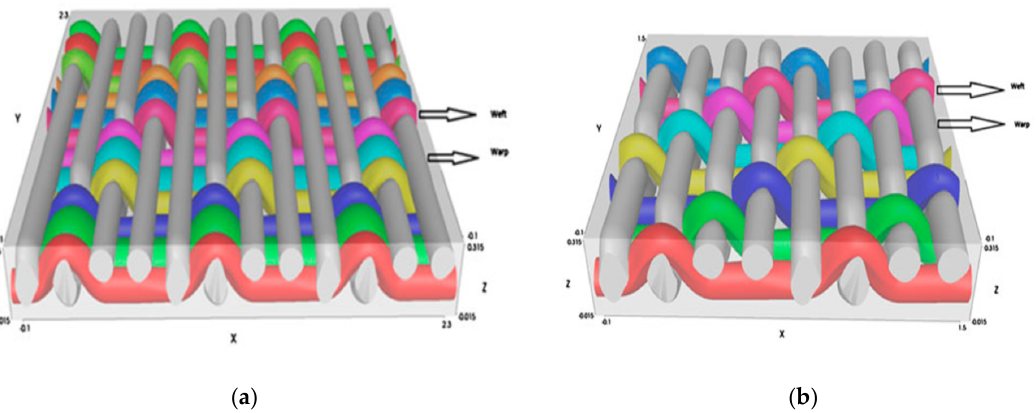
Figure 2. Cross ‐ sectional view of ( a ) 3PI with 3/1 twill weave design and ( b ) 3/1 twill weave design. [106] Effect of woven fabric structure on the air permeability and moisture management properties Umair et al., The Journal of The Textile Institute. Copyright © The Textile Institute, reprinted by permission of Taylor & Francis Ltd., http://www.tandfonline.com on behalf of The Textile Institute.